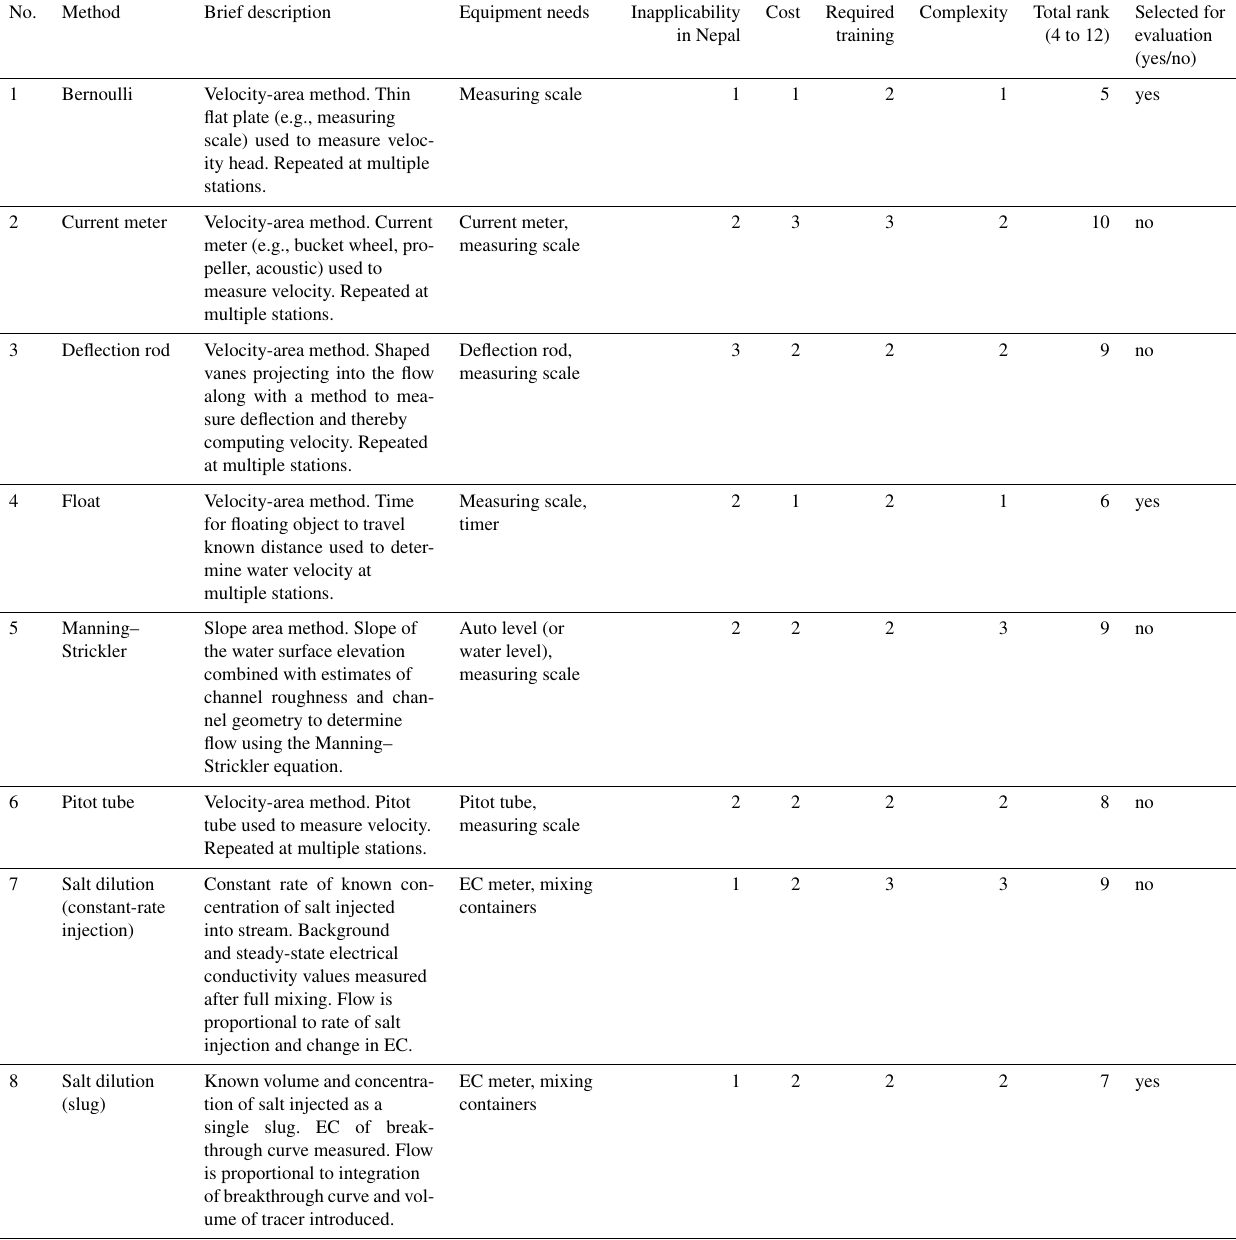
Table 1. Summary of simple streamflow measurement methods considered for further evaluation. Integer ranks of 1, 2, or 3 for inapplicability in Nepal (especially for smaller headwater catchments); cost; required training; and complexity were given to each method, with 1 being most favorable and 3 being least favorable. The three methods with the lowest rank were selected for further evaluation. Smartphones are not included in equipment needs because it was assumed that citizen scientists would provide these themselves. EC: electrical conductivity.